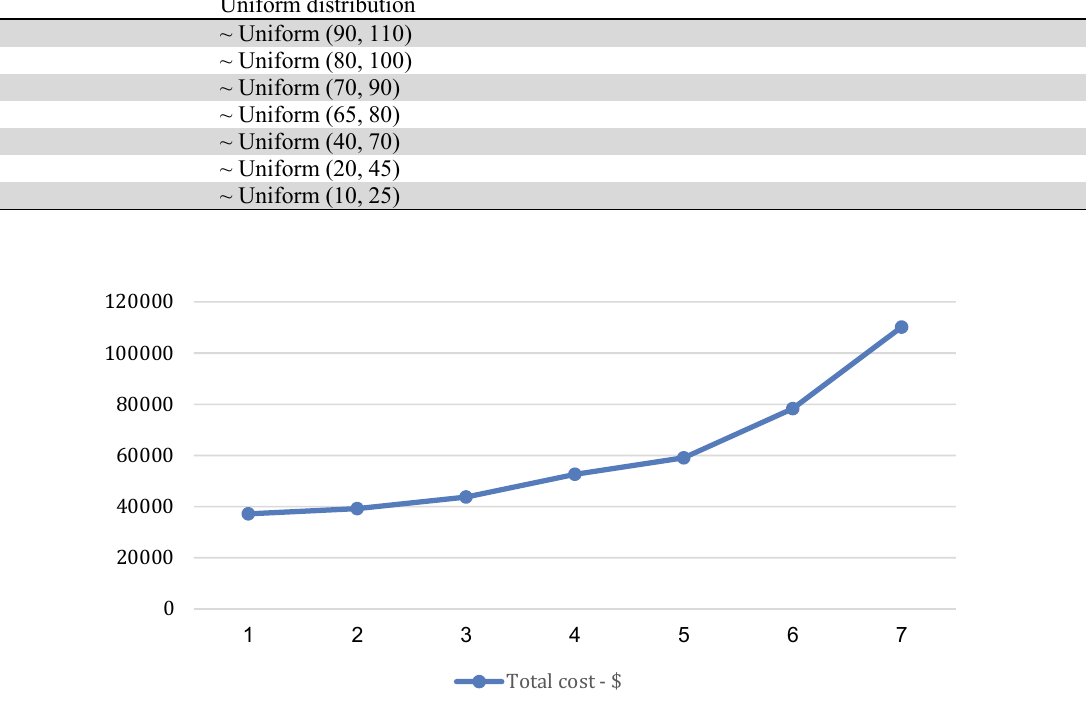
Fig. 7. Sensitivity of total costs by variation the donation capacity